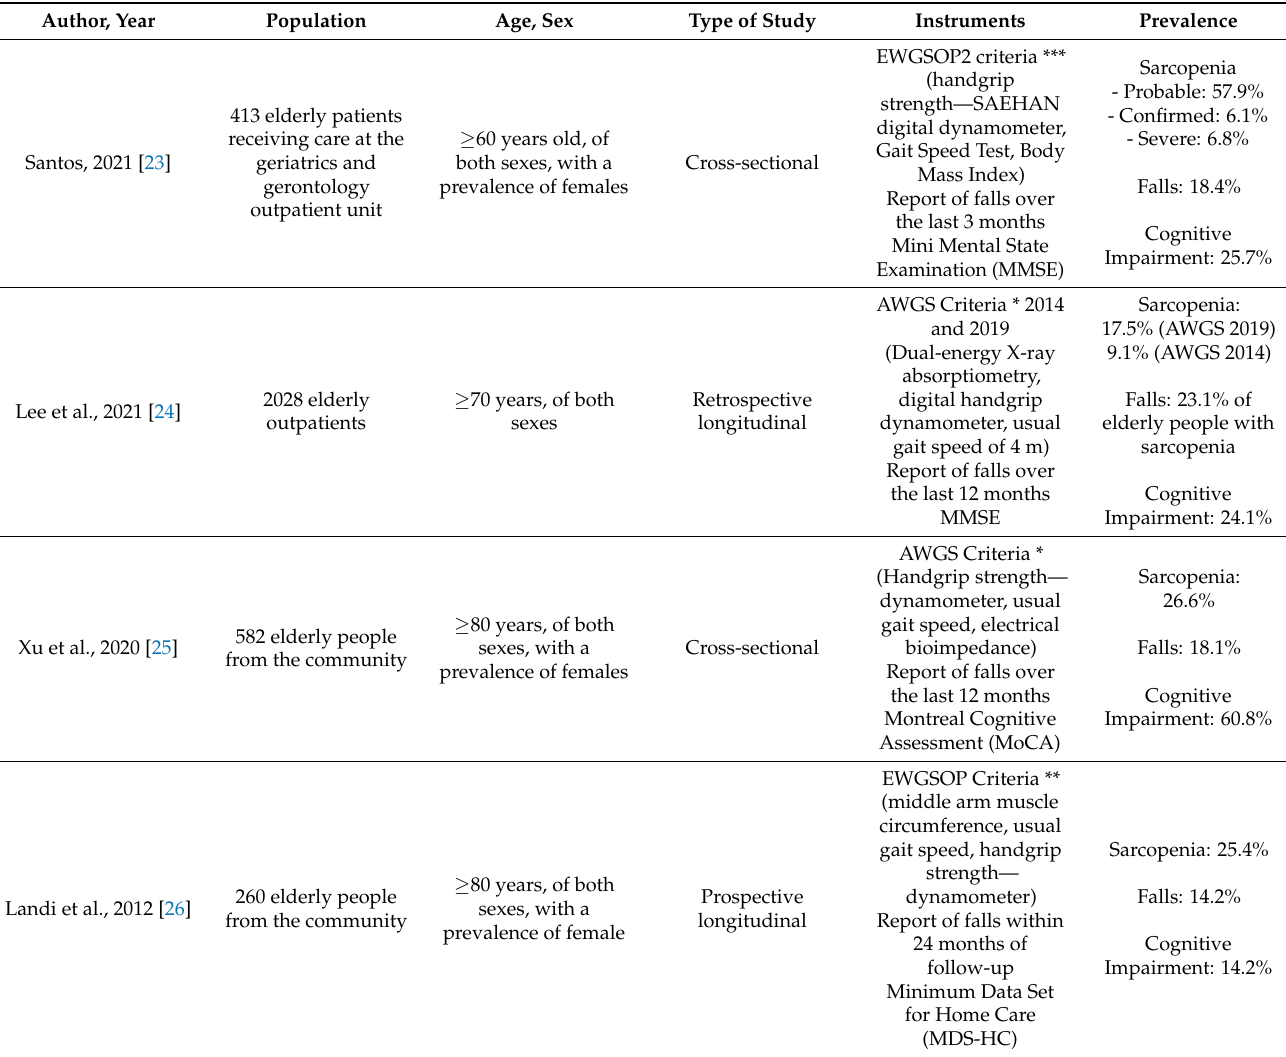
Table 2. The estimated prevalence of cognitive impairment, falls, and sarcopenia from the studies included in the systematic review, S ã o Paulo, SP, Brazil,